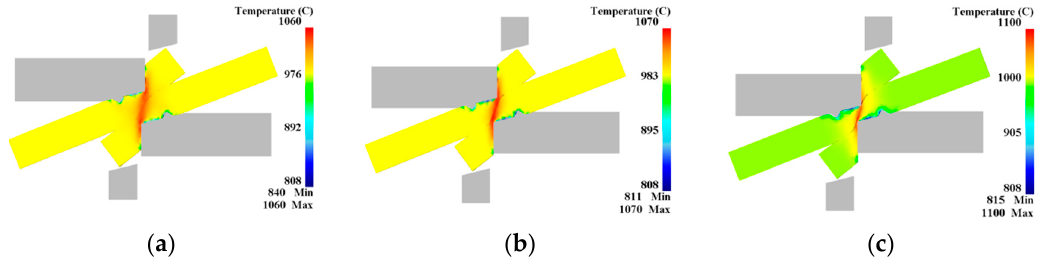
Figure 16. Temperature changes during the shear connection process: ( a ) L = 100%; ( b ) L = 125%; ( c ) L = 150%.